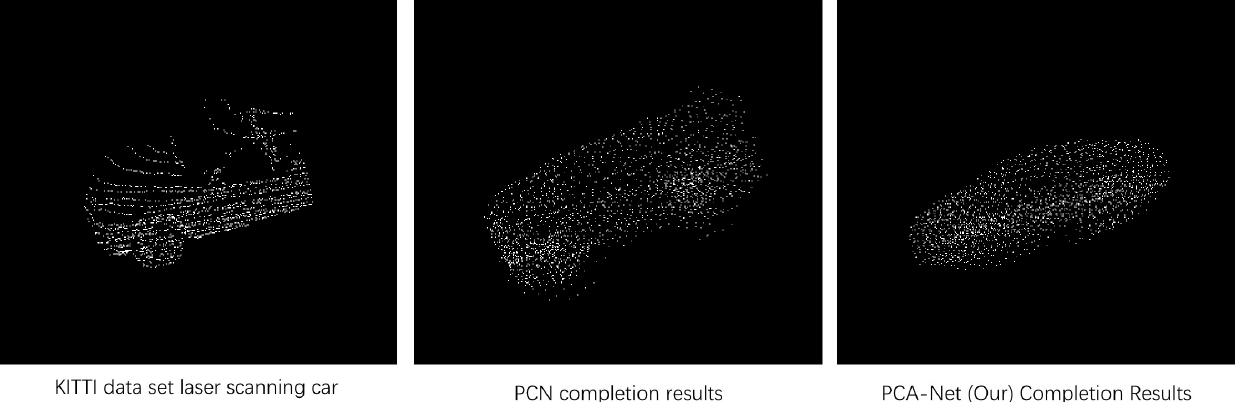
Figure 7. LIDAR-captured car point clouds (missing point clouds) in the KITTI dataset, with comple- tion results on PCN [3] and